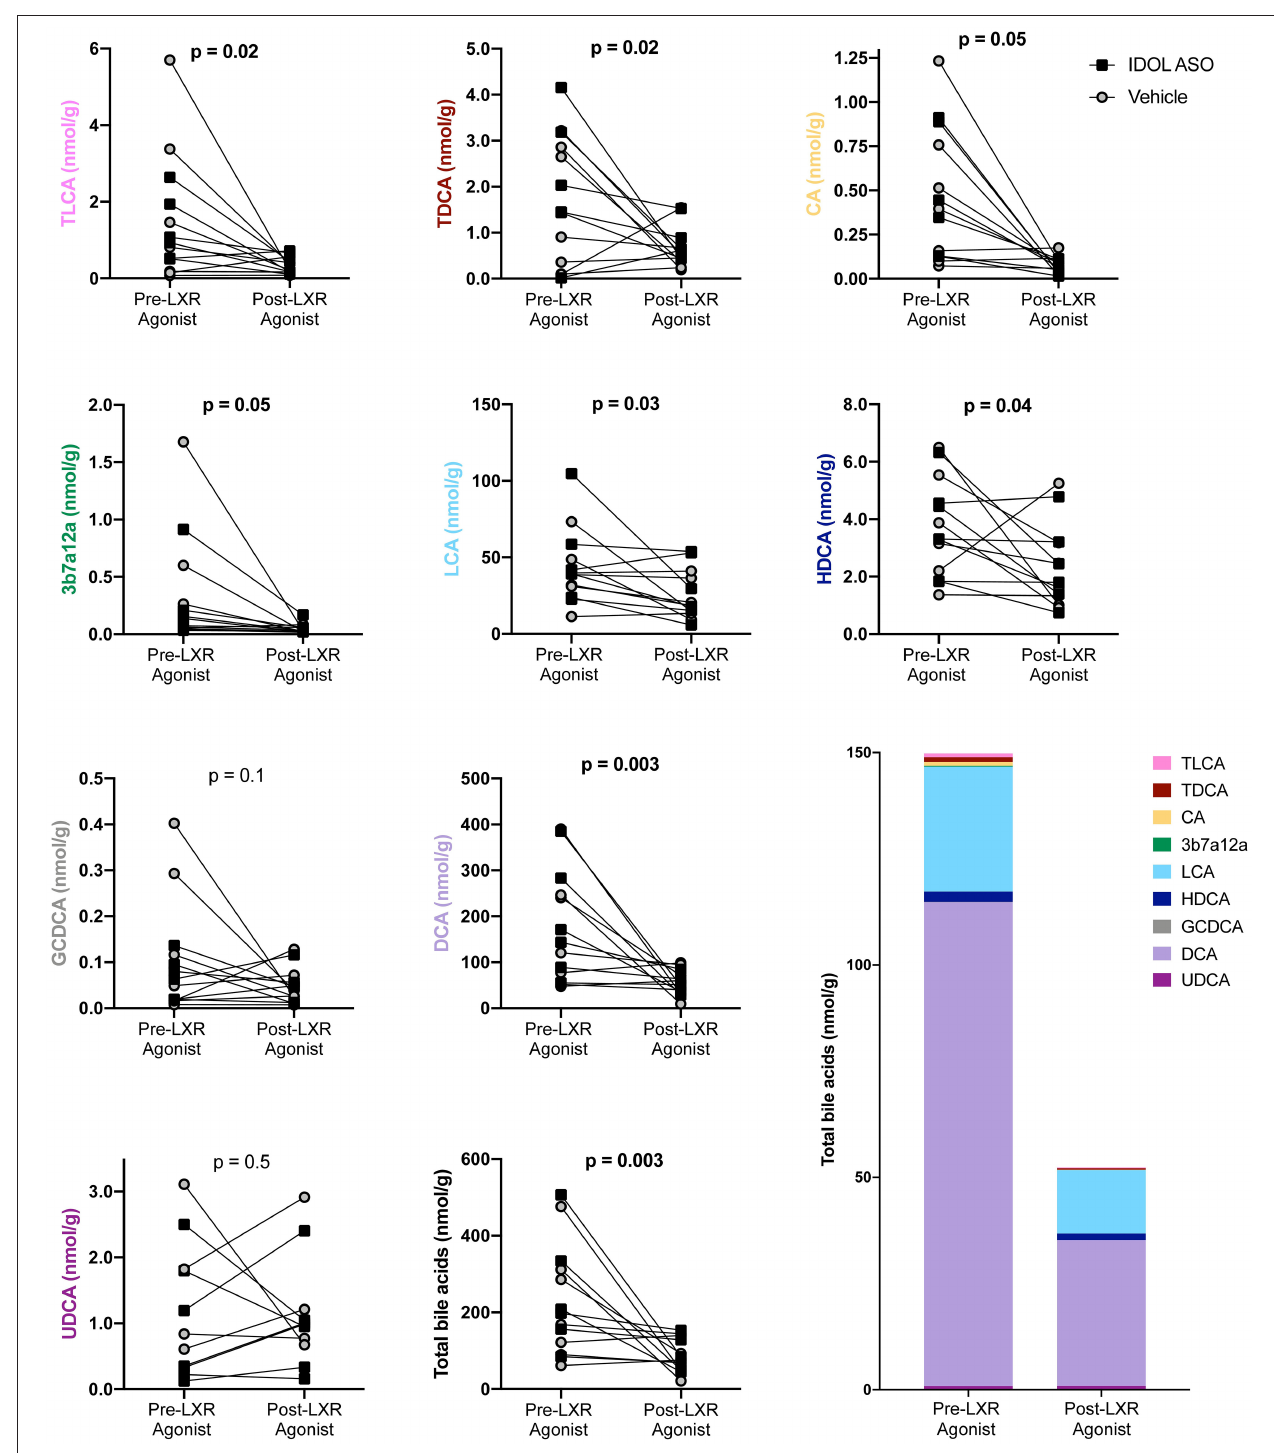
FIGURE 6 | The LXR agonist decreased fecal bile acids. Data were analyzed with a two-way ANOVA for IDOL ASO and LXR Agonist treatments. There were no significant differences due to IDOL ASO, and the p -values plotted refer to the effect of the LXR treatment. P = 0.03) and TDCA (rho = 0.63, P = 0.03). In general, the LXR P = 0.006), CA (rho = − 0.72, P = 0.006), total bile acids (rho = − 0.68, P = 0.01), and 3b7a12a (rho = − 0.63, P = 0.006), while agonist decreased fecal bile acid levels, and data was analyzed with a two-way ANOVA to account for the IDOL ASO and LXR Ruminococcus was positively correlated with TLCA (rho = 0.65,